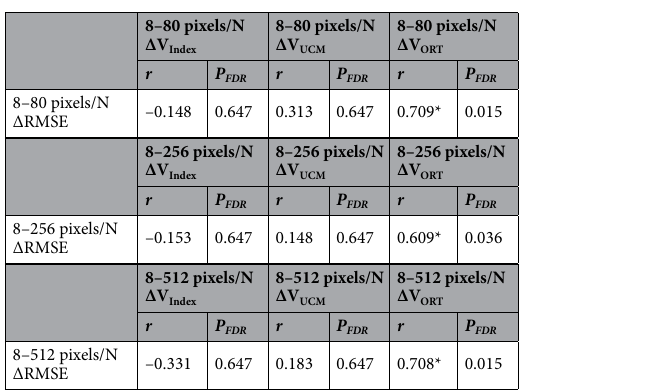
Table 1. Correlation findings between changes in RMSE and UCM variables. FDR false discovery rate. * P FDR <